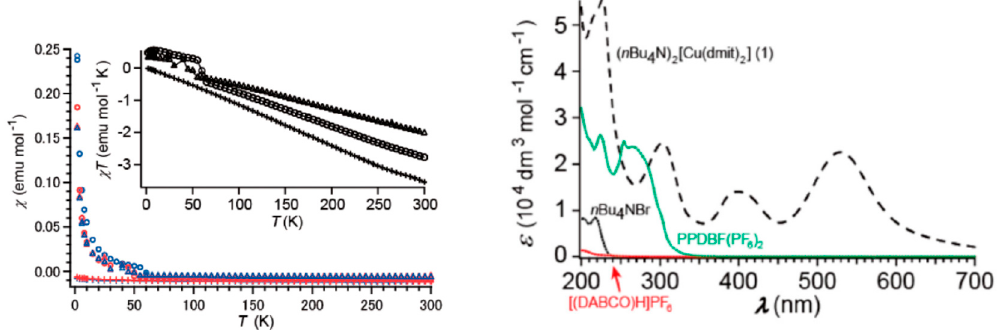
Figure 2. ( left ) Temperature dependence of the magnetic susceptibility of [n-Bu 4 N] 2 [Cu(dmit) 2 ] (circles) and two related compounds: [(DABCO)H] 2 [Cu(dmit) 2 ]CH 3 CN (crosses) and BP 2 DBF[Cu(dmit) 2 ] (triangles). Blue and red circles correspond to field-cooling and zero-field-cooling measurements, respectively. ( right ) UV–Vis absorption spectra of [n-Bu 4 N] 2 [Cu(dmit) 2 ] in CH 3 CN at 20 ◦ C. The UV–Vis-near infrared (NIR) diffuse reflectance spectra in KBr differ by the relative intensity of the bands, but not for the position of these bands. From Ref. [23].